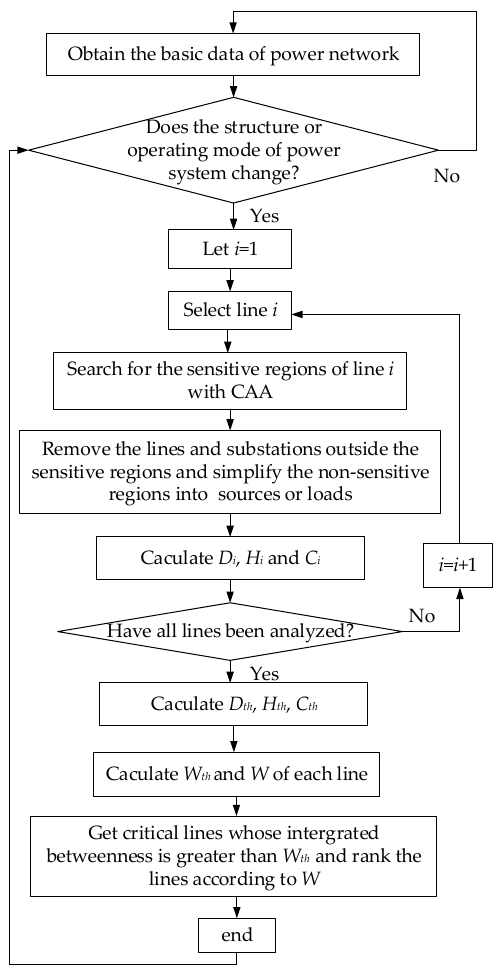
Figure 1. The flow chart of the proposed identification method.